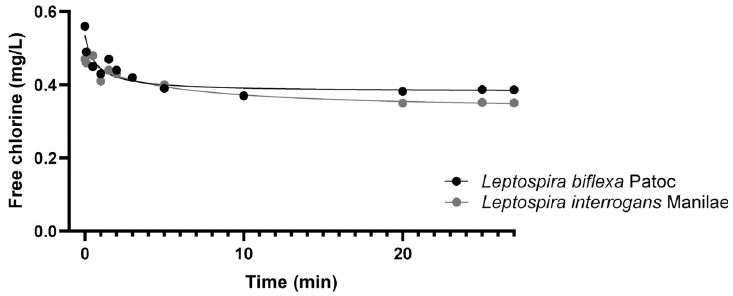
Fig 5. Free chlorine consumption kinetics for L . biflexa serovar Patoc and L . interrogans serovar Manilae. The time of exposure to free chlorine was adjusted to maintain a CT-value equal to 10 mg.min.L - 1 .